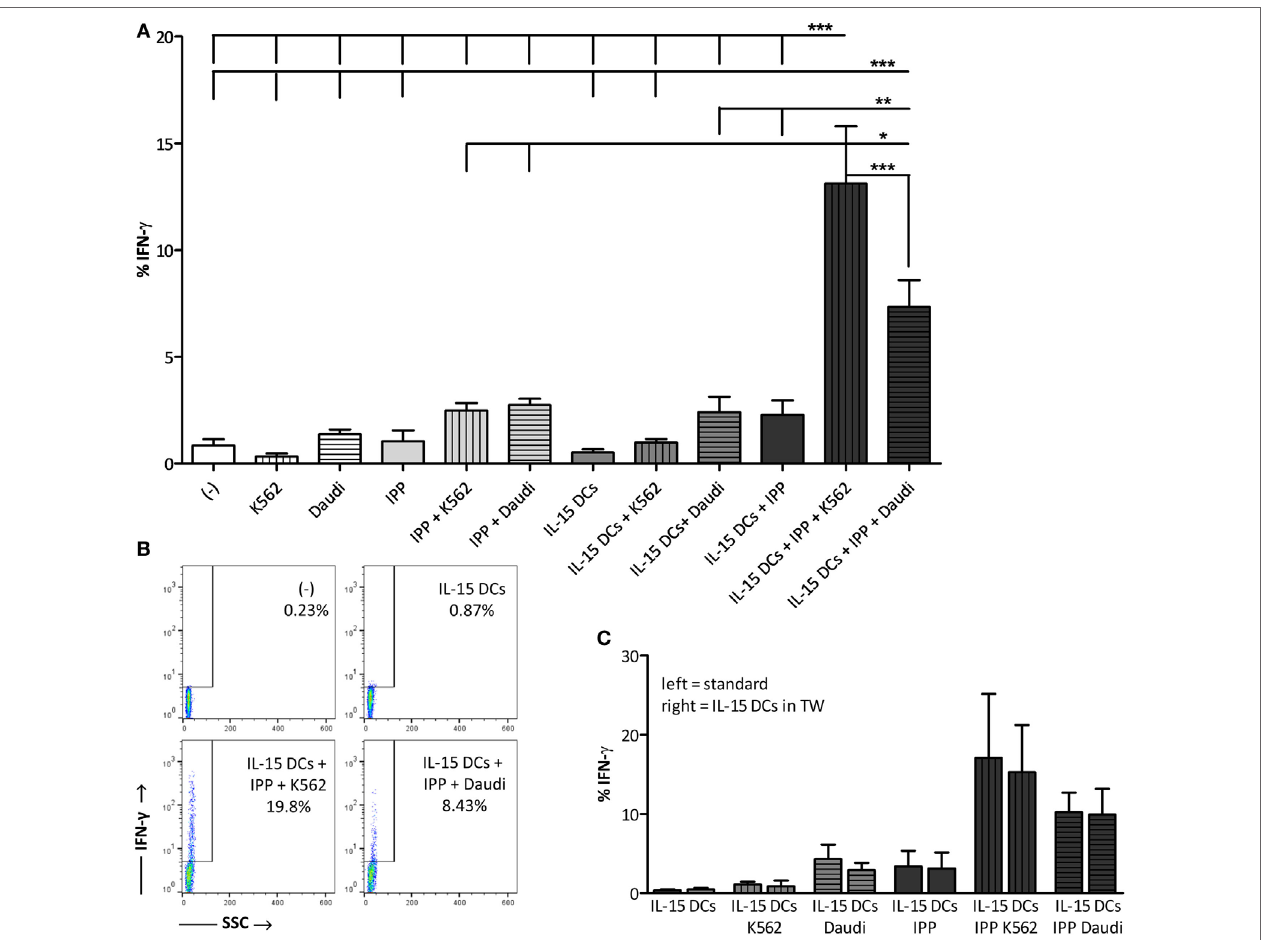
FigUre 2 | IL-15 dendritic cells (DCs) stimulate γδ T cell IFN- γ production in the presence of a leukemic environment through a contact-independent mechanism (a) γδ T cells in full peripheral blood mononuclear cell fraction were examined for IFN- γ production by intracellular staining after overnight stimulation with isopentenyl pyrophosphate (IPP), IL-15 DCs (E:T ratio = 1:10), tumor cells (E:T ratio = 1:10), and all possible combinations. Resting γδ T cells ( − ) were used as negative point of reference. Data are depicted as the mean of ten independent donors. One-way ANOVA with Bonferroni’s Multiple Comparison Test. (B) Representative FACS dot plots of one healthy donor out of 10 showing IFN- γ production by γδ T cells. (c) In parallel, the same experiment was carried out except that IL-15 DCs were separated from the cultures by 0.4-µm transwell (TW) inserts ( n = 3). *** p < 0.001, ** p < 0.01, and * p <